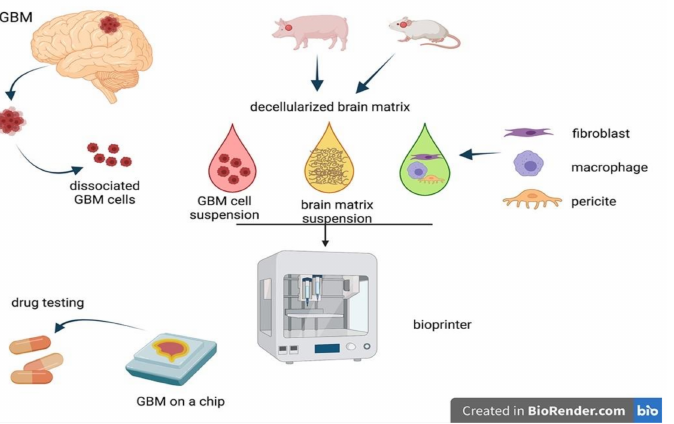
Figure 3. The bio-printing technique is used to create GBM on a chip. GBM cells obtained from a patient are stratified with decellularized brain matrix and other human cells present in the tumor niche. The GBM on a chip may then be used for drug